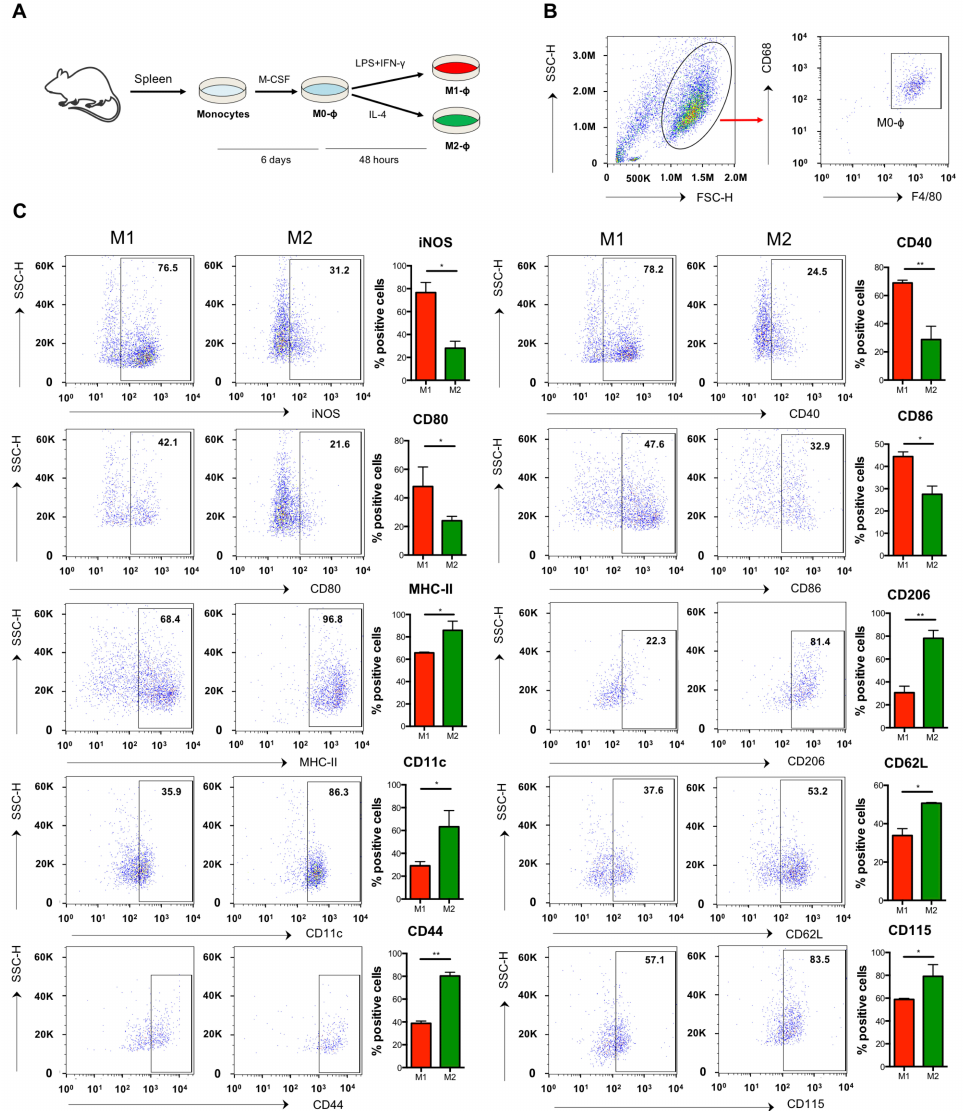
Figure 1. Immunophenotype of M1 and M2 macrophages obtained from CFA mice. ( A ) Mono- cytes obtained from spleen of CFA mice were differentiated into macrophages using M-CSF (50 ng/mL) for 6 days and then polarized into M1 with IFN- γ (10 ng/mL) plus LPS (1 µ g/mL) or into M2 with IL-4 (20 ng/mL) for two more days. ( B ) Representative flow cytometry plot showing the gating strategy to identify monocyte-derived macrophages ( C ) Expression of markers by flow cytometry upon staining cells at cell surface (CD40, CD11b, MHC-II, CD80, CD86, CD25, CD206, CD11c, CD62L, CD44, CD115, and CCR5) or intracellularly (iNOS). Data are reported as percentage of positive cells and are representative of 10 independent experiments ± SEM * p < 0.05; ** p <